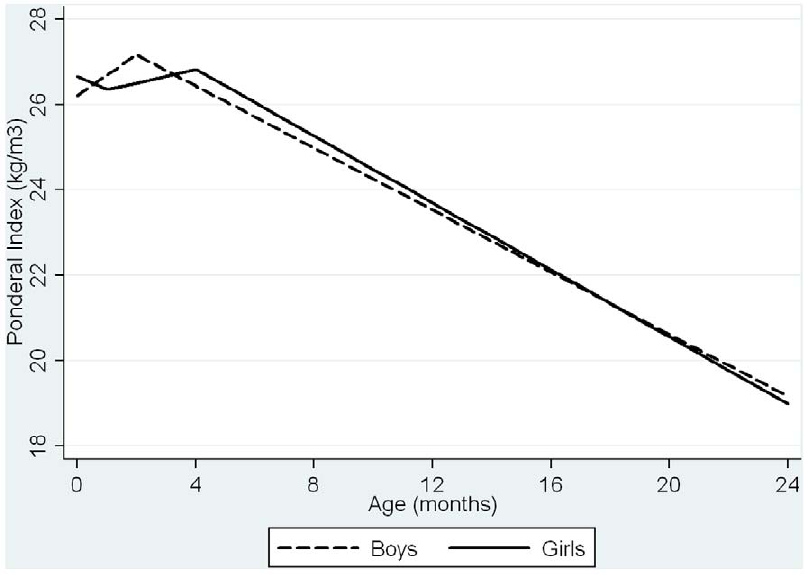
Figure 1. Boys Overall PI/BMI trajectories predicted by random effects models.